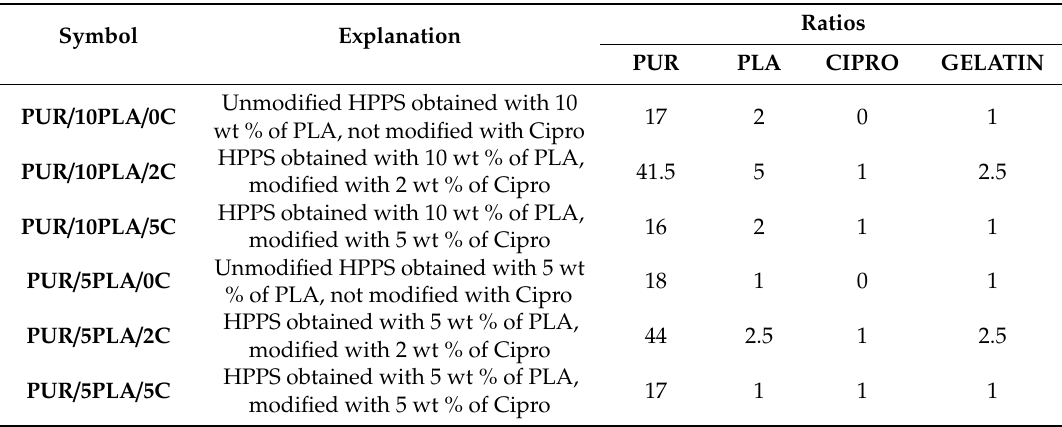
Table 1. Symbols and ratios of unmodified and Cipro-modified hybrid biocompatible polyurethane- polylactide (PUR-PLA) sca ff olds (HPPSs) with a brief